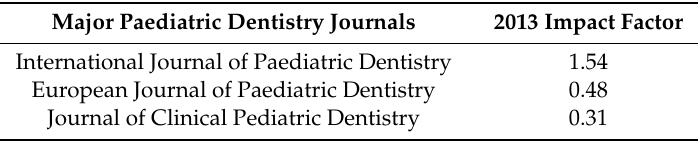
Table 1. Major PD journals and their 2013 impact